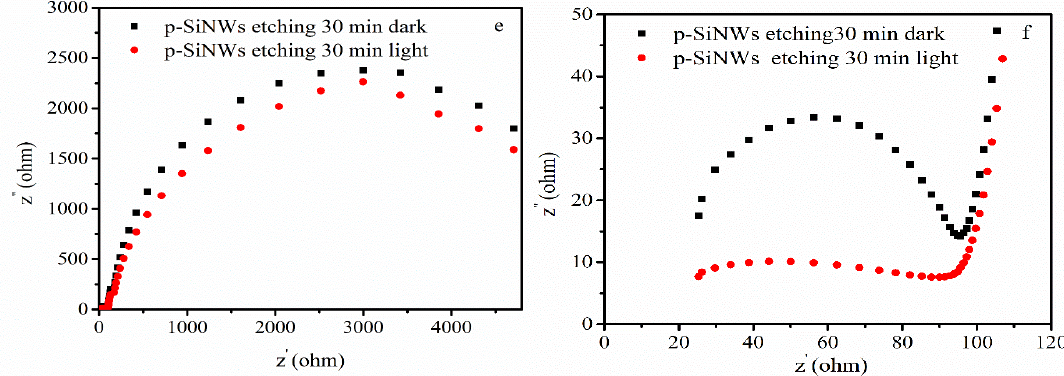
Figure 10: The impedance spectra of (a) p-Si, (b) magnification for high-frequency region for p-Si, (c) p- SiNWs prepared by etching 15 min, (d) magnification for high-frequency region for p-SiNWs prepared by etching 15 min, (e) p- SiNWs prepared by etching 30 min, (f) magnification for high-frequency region for p- SiNWs prepared by etching 30